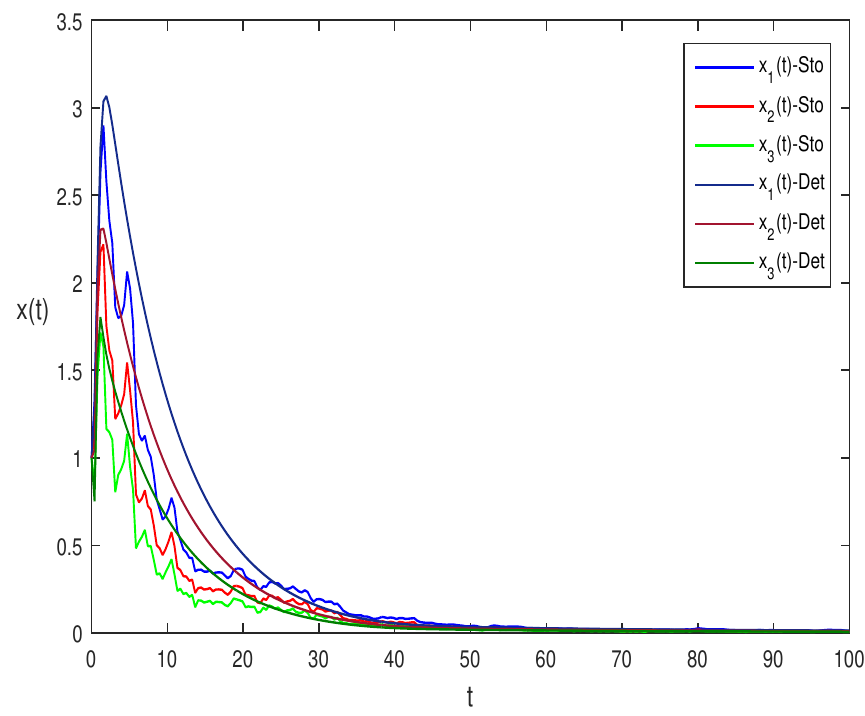
Figure 6. Comparisons of the stable solutions for each class of stochastic delay NGM systems from Equation (1) with the deterministic model, σ i = 1, ( i = 1,2,3 )